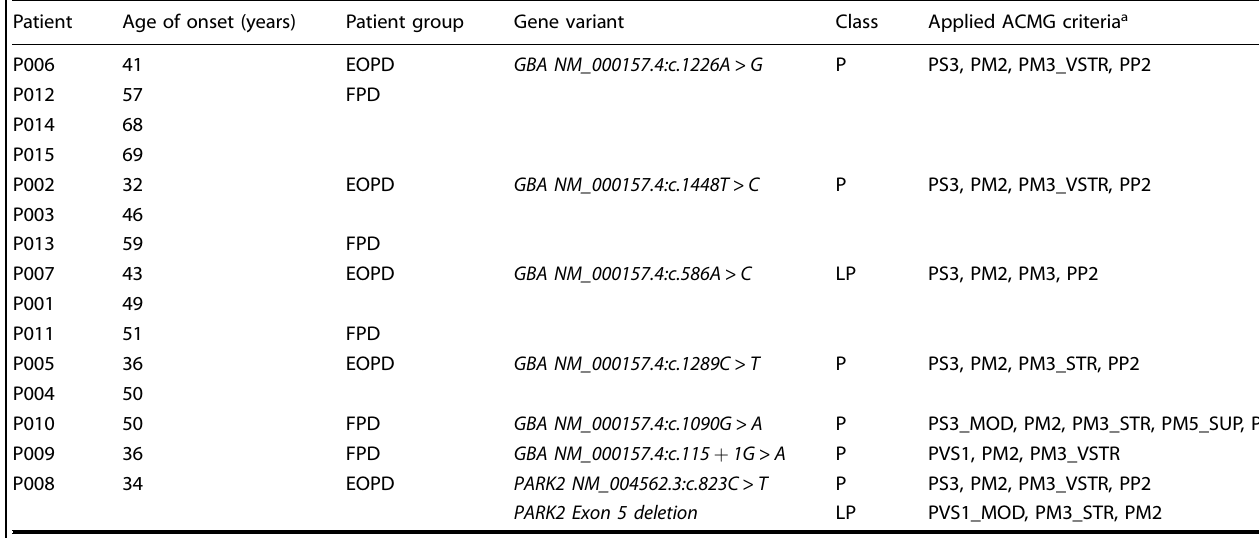
Table 2. Causative pathogenic and likely pathogenic variants. Patient Age of onset (years) Patient